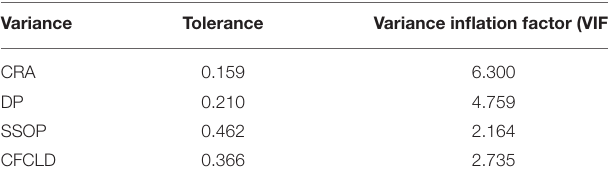
TABLE 5 | Tolerance and variance inflation factor of CBPLC four